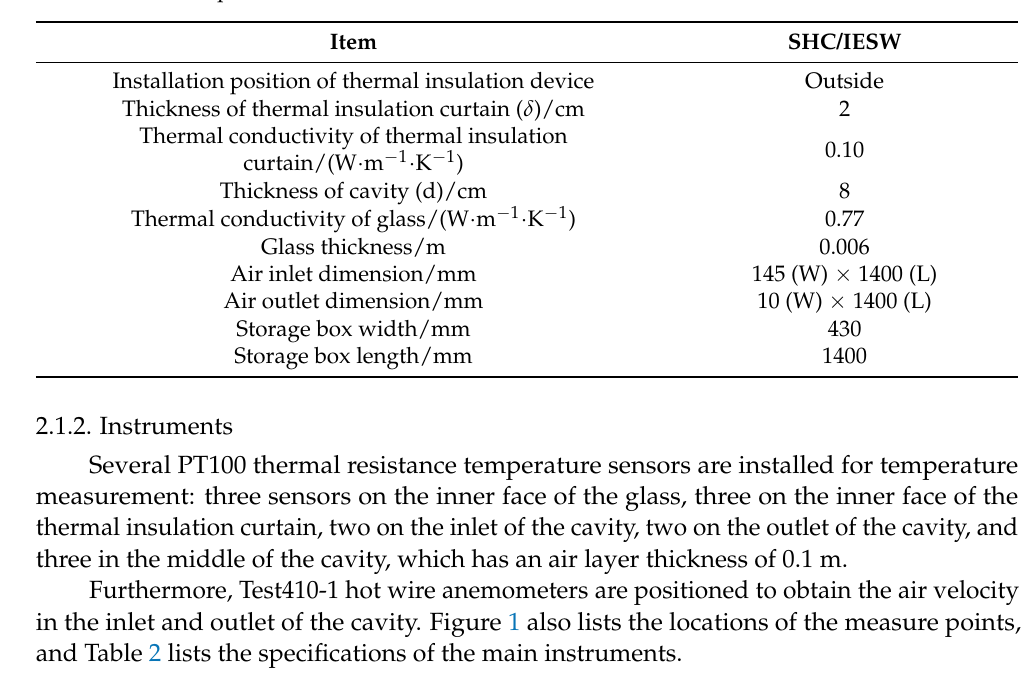
Table 2. Specifications of the main